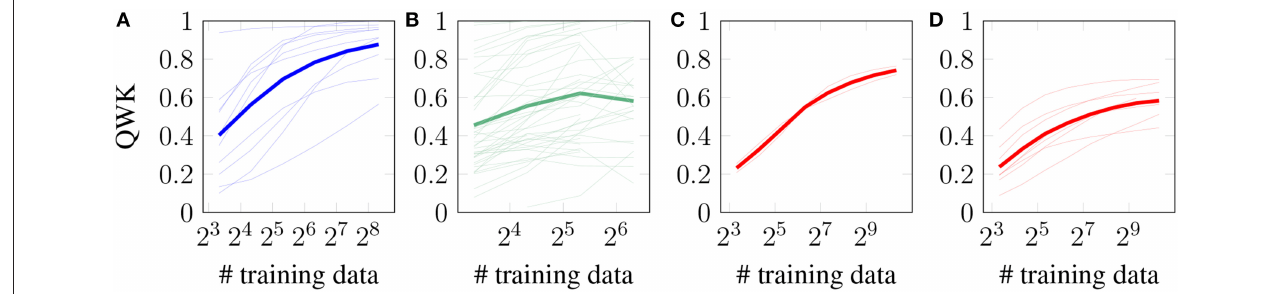
FIGURE 6 | Instance-based learning curves for datasets with different average lengths. Thin lines are individual prompts, while the thick line is the average for this dataset. (A) very short (POWERGRADING). (B) short (SRA). (C) medium (ASAP short). (D) long (ASAP